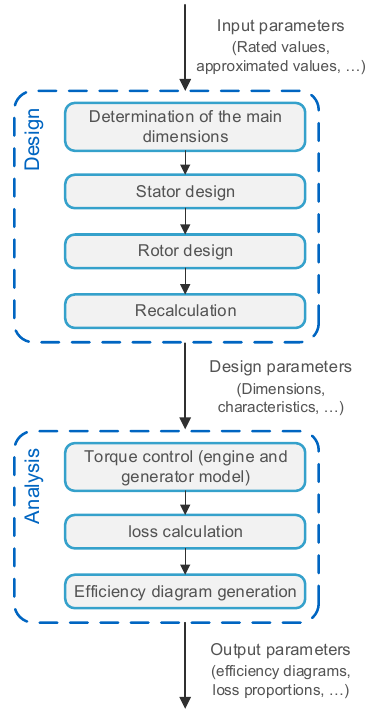
Figure 3. Overview of implemented electric machine design model.